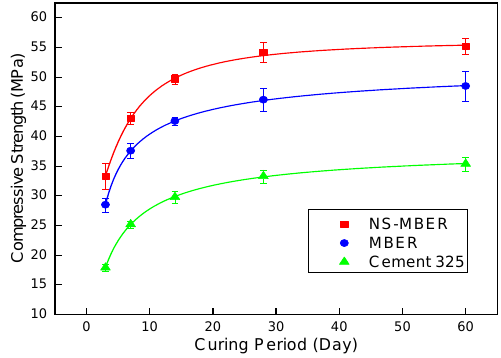
Figure 5. Intensity diagram of NS-MBER, MBER and cement.